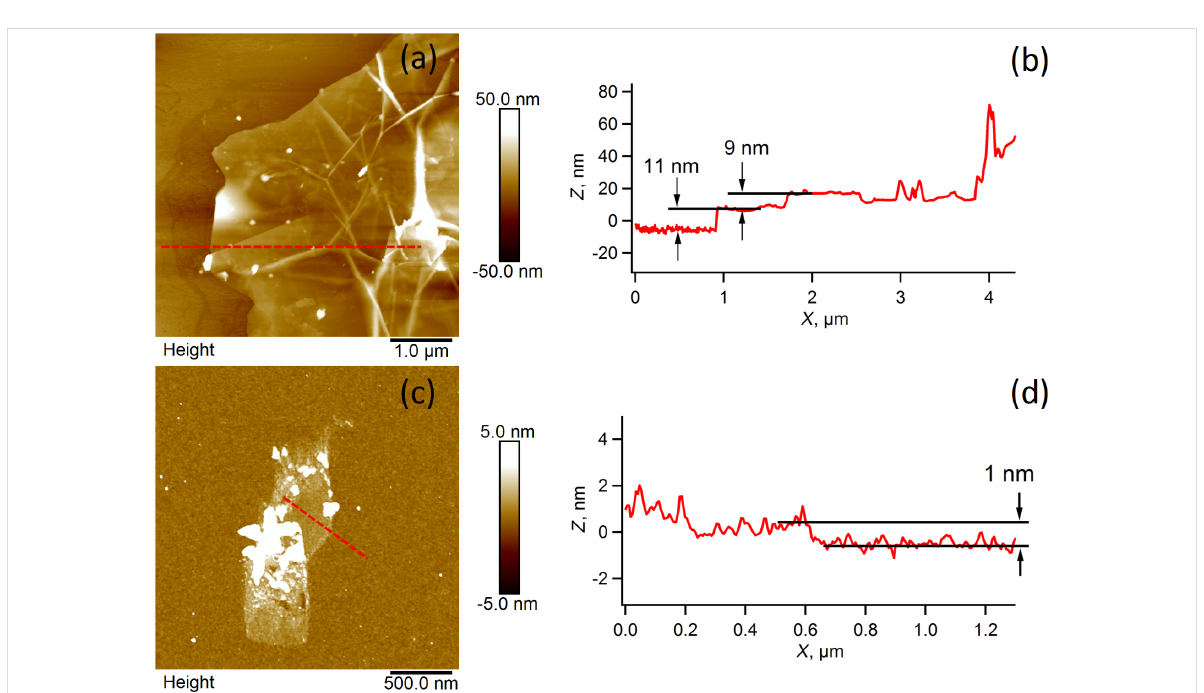
Figure 2: a) and b) AFM detail and profile of a multi-layer graphene (MLG) flake, ca. 10 graphene layers, c) and d) AFM detail and profile of a few- layer graphene (FLG) flake, ca. 1–6 graphene